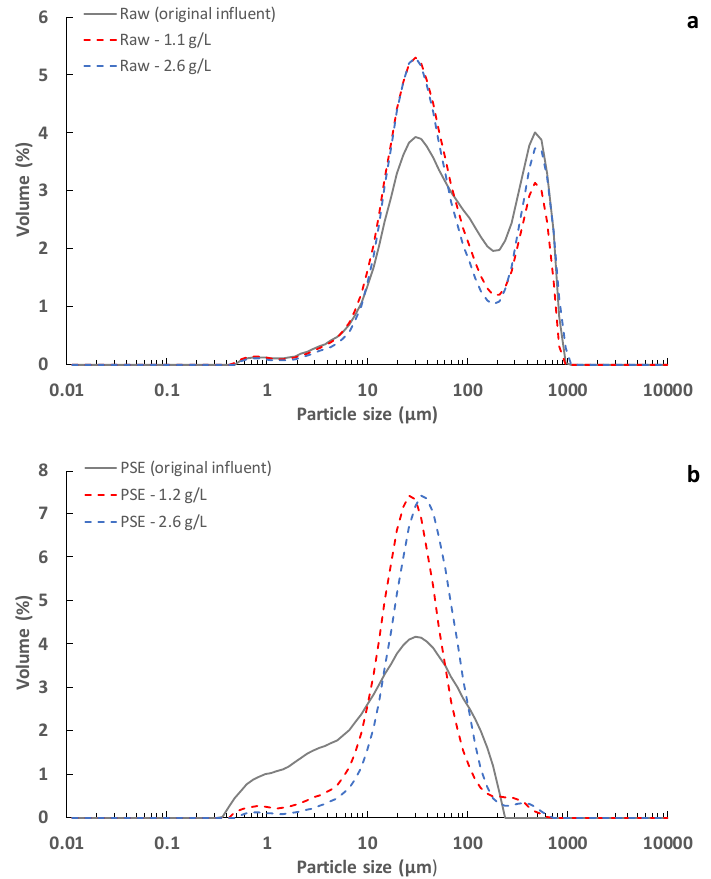
Figure 4. Particle size distribution of the different influents treated during the ultrafiltration mem- brane operation: ( a ) raw and ( b ) PSE. Note that the legend shows the influent treated together with the average operating total suspended solids concentration. Raw: influent municipal wastewater after a classic pre-treatment (screening and sieving, desanding and degreasing). PSE: effluent of the full-scale wastewater treatment plant primary settler. Table 4. SMP concentration, viscosity and filterability of the treated sludge during the ultrafiltration membrane operation.